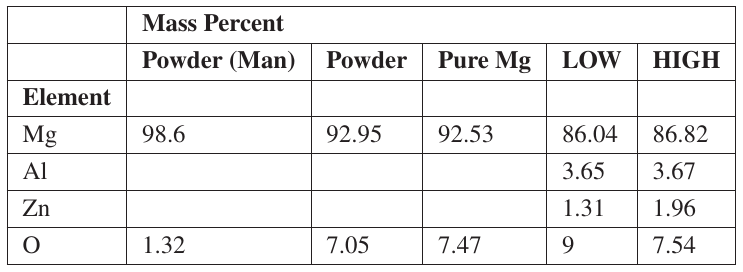
Table 2. Chemical composition of as received powder and sintered compacts. Powder (Man) is the chemical analysis provided by the manufacturer of the Mg powder. Powder is the Mg powder composition determined by EDS. Pure Mg was an un-alloyed sample compacted at 500 MPa, sintered at 500 °C for 60 min, quenched at 500 °C. LOW is P/M AZ31 alloy compacted at 500 MPa, sintered at 500 °C for 20 min, quenched at 450 °C. HIGH is P/M AZ31 alloy com- pacted at 500 MPa, sintered at 600 °C for 60 min, and quenched at 450 °C.